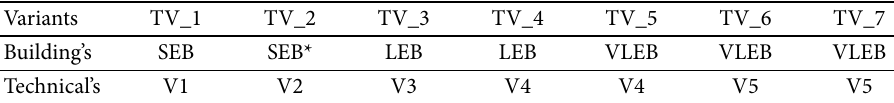
Table 3. Description of the analysed variants